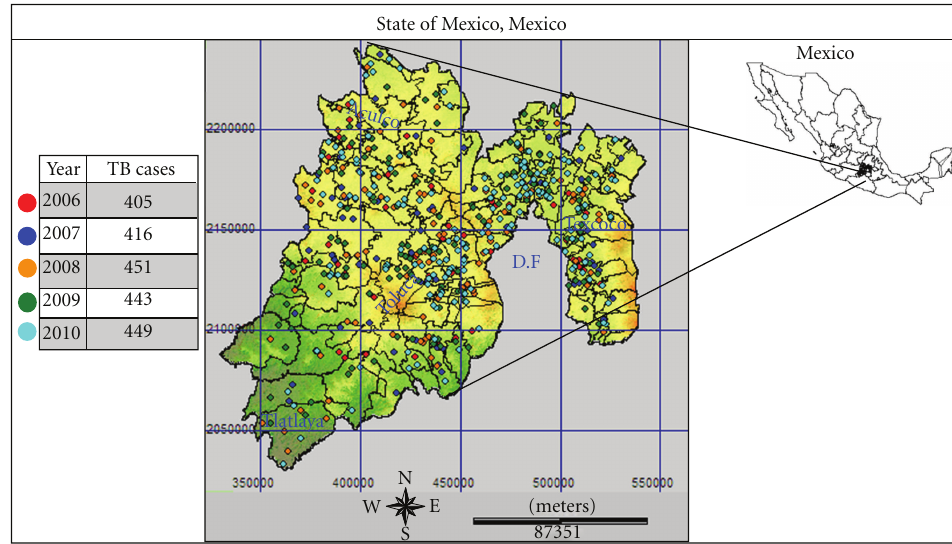
Figure 1: Location and geographic distribution of tuberculosis cases during 2006–2010 in the State of